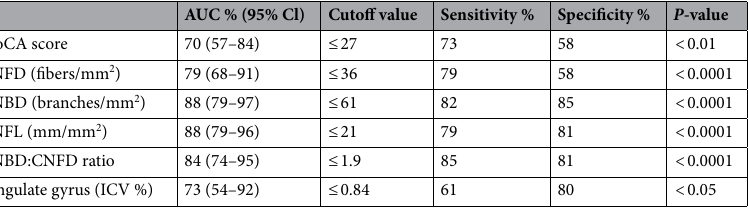
Table 3. Diagnostic accuracy of montreal cognitive assessment (MoCA), corneal confocal microscopy (CCM) and cingulate gyrus volume for schizophrenia. AUC area under the curve, CNFD corneal nerve fiber density, CNBD branch density, CNFL fiber length.